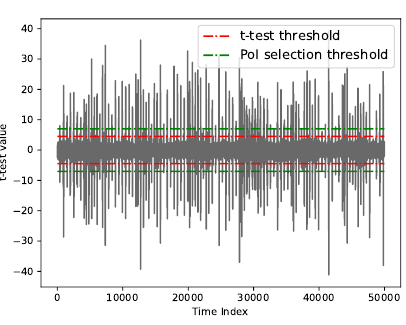
Figure 3: TVLA results for LAC ( LAC128 ) between decoding of valid ( c = 0) and invalid ( c = 1) codeword